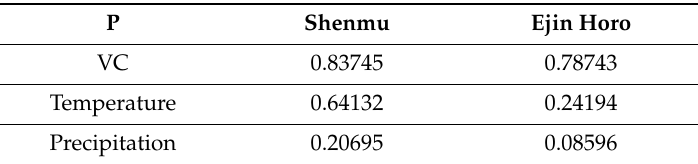
Table 6. Data normality test results.